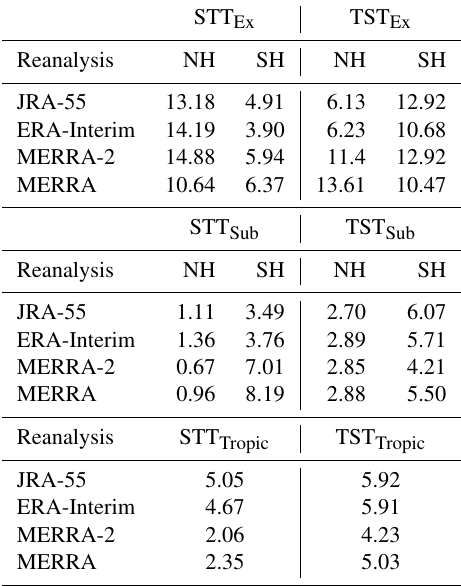
Table 2. STT and TST annual cycle amplitudes in the extratropics, subtropics, and the tropics from each reanalysis model. All ampli- tudes are in units of 10 9 kgs − 1 and annual cycles for the extratrop- ics and subtropics are separated by